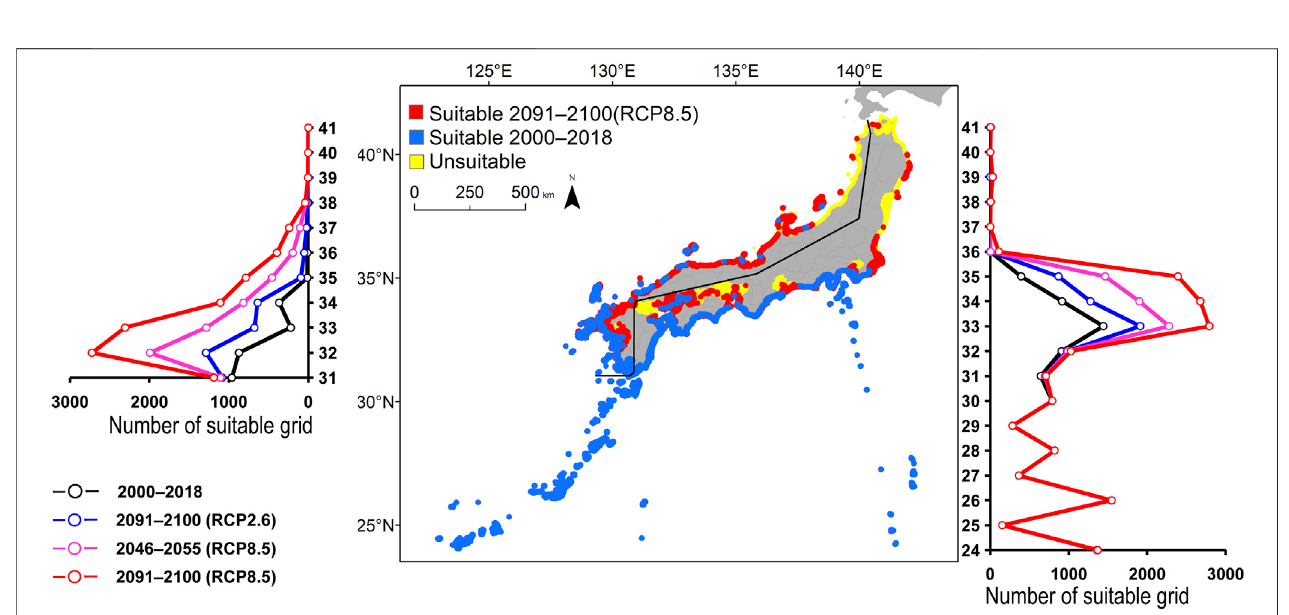
FIGURE 6 | Estimated distribution of Amphiprion frenatus . See Figure 2 for the explanation.